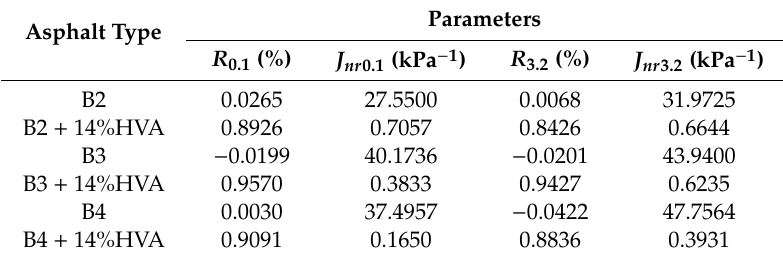
Table 4. Results of creep recovery rate and non-recoverable creep